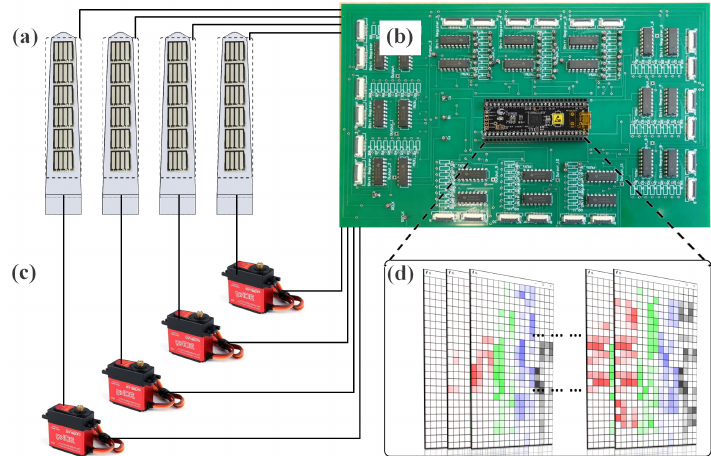
Figure 2. System architecture. ( a ) data collection; ( b ) data processing; ( c ) control and manipulation; ( d ) tactile perception (tactile data collected in four fingers will be represented with red, green, blue and gray colors in the visualisation, larger force applied on the sensing area will generate darker shade of the color).